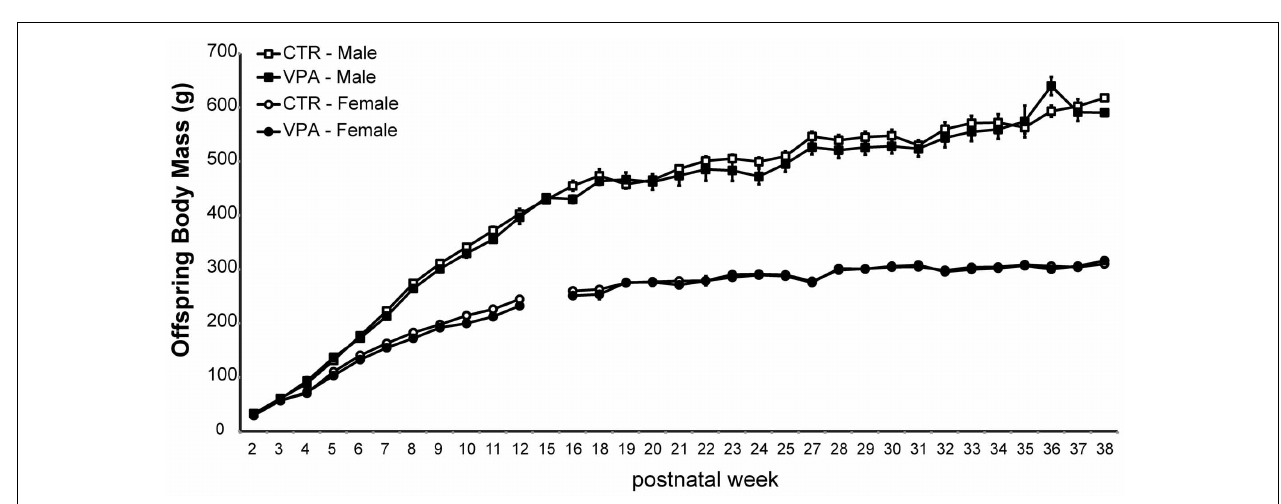
treatment. (B) Litter size (number of pups born) is not different between treatments. Data shown as mean ( M ) and standard error of the mean ( S.E.M. ).